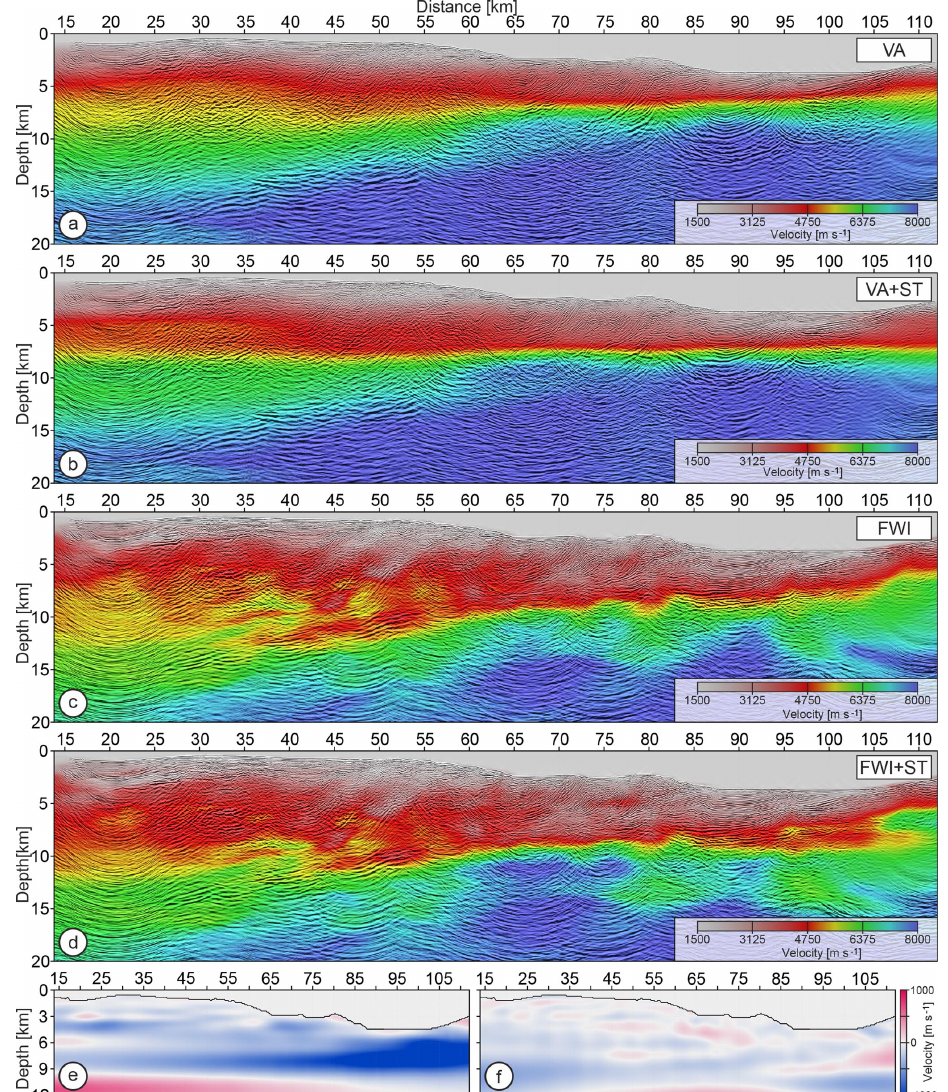
Figure 8. PSDM sections inferred from the (a) VA, (b) VA+ST, (c) FWI and (d) FWI+ST velocity models displayed in the background. Velocity perturbations introduced by ST into the (e) VA and (f) FWI velocity